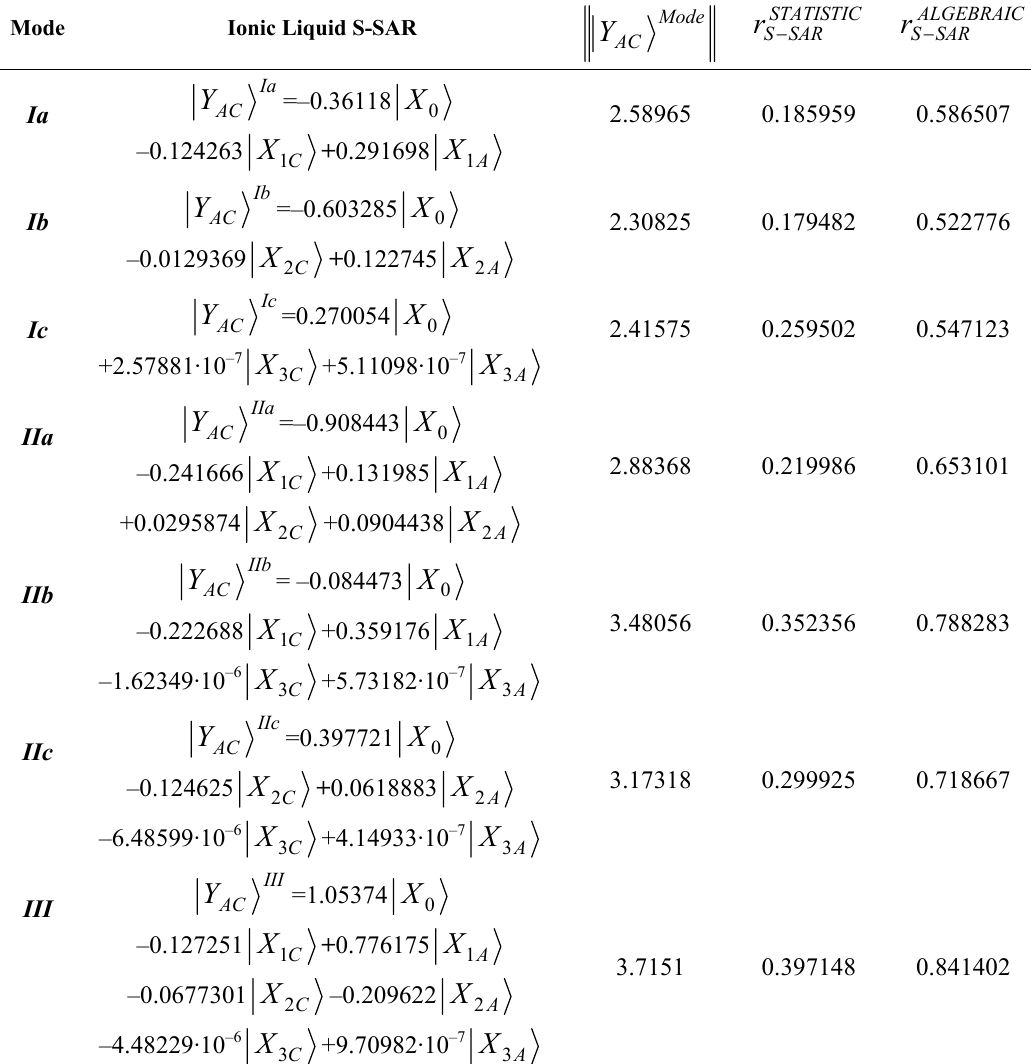
Table 5: Spectral structure activity relationships (S-SAR) of the ionic liquids of Figure 2 against Vibrio fischeri toxicity, and the associated computed spectral norms with ║ | Y > ║ = 4.41537 , statistic and algebraic correlation factors, computed upon the relations EXP (6), (7), and (8), through all possible correlation models considered for the cationic- anionic interaction (11), respectively. Mode Ionic Liquid S-SAR Mode